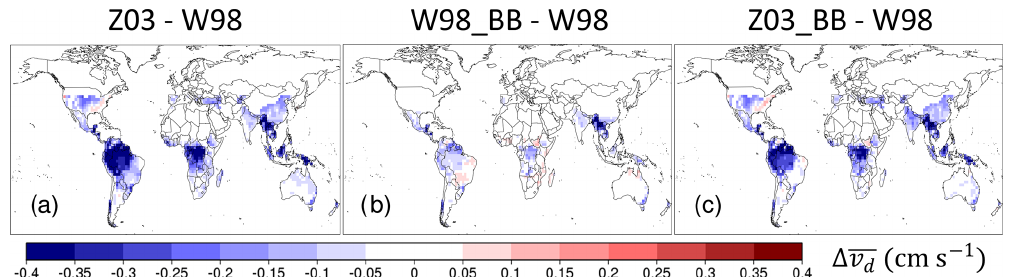
Figure 6. Differences of 1982–2011 December mean daytime v d ( (cid:49)v d ) between three other parameterizations (Z03, W98_BB, and Z03_BB) and W98 over vegetated land surface.